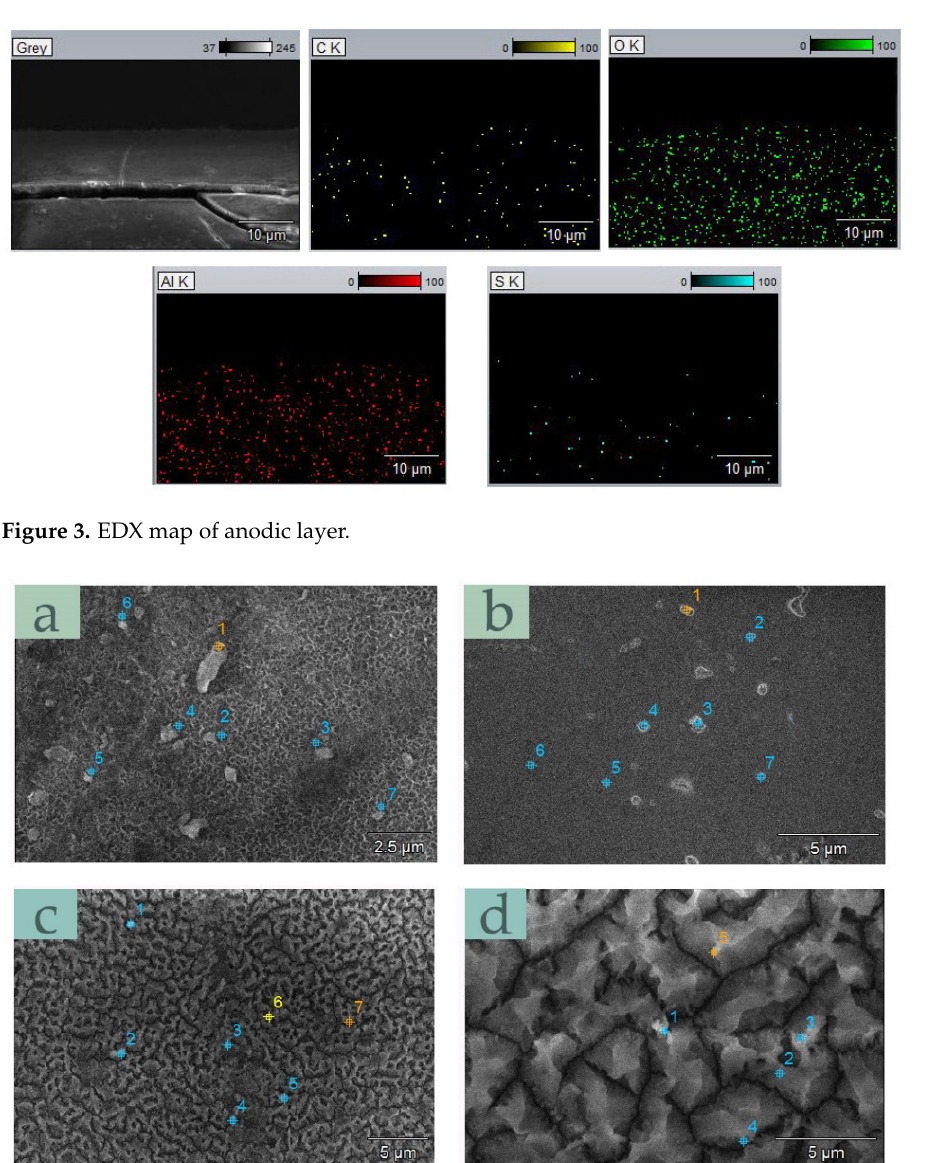
Figure 4. SEM images of specimens of groups ( a ) AT-3, ( b ) AT-6, ( c ) BT-3, and ( d )